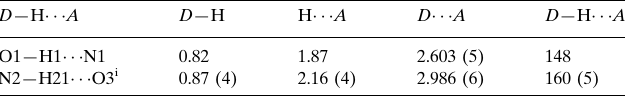
Hydrogen-bond geometry (A˚ , (cid:1)